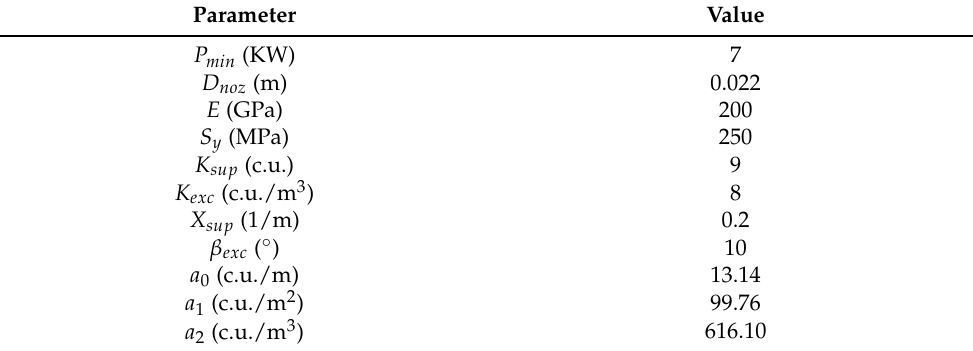
Table 1. Summary of the scenario parameters considered for the